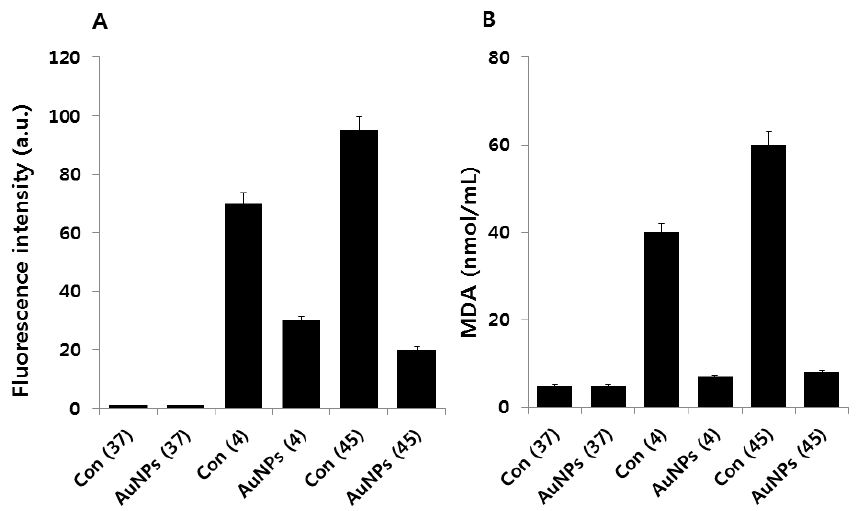
Figure 4. Effect of AuNPs on cold and heat stress-induced ROS generation. ( A ) E. coli cells were pre-incubated with AuNPs (1 μ g/mL) for 1 h, stressed at 4 °C or 45 °C, and subsequently recovered for 12 h at 37 °C. ROS generation was measured by DCFDA. Data are shown as means and standard deviations calculated from three independent experiments. AuNP-treated groups showed statistically significant differences from the control group by Student’s t -test ( p < 0.05); ( B ) E. coli cells were pre-incubated with AuNPs (1 μ g/mL) for 1 h, stressed at 4 °C or 45 °C, and subsequently recovered for 12 h at 37 °C. The MDA level was measured by TABARS assay. Data are shown as means and standard deviations calculated from three independent experiments. AuNP-treated groups showed statistically significant differences from the control group by Student’s t -test ( p <